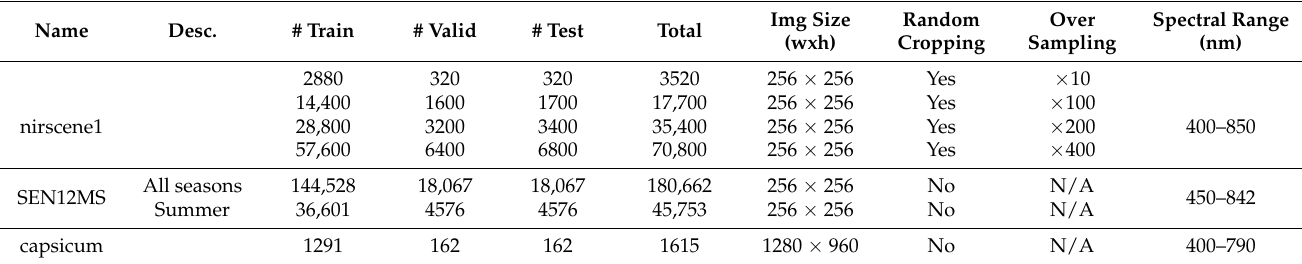
Table 2. Summary of datasets used for generating synthetic